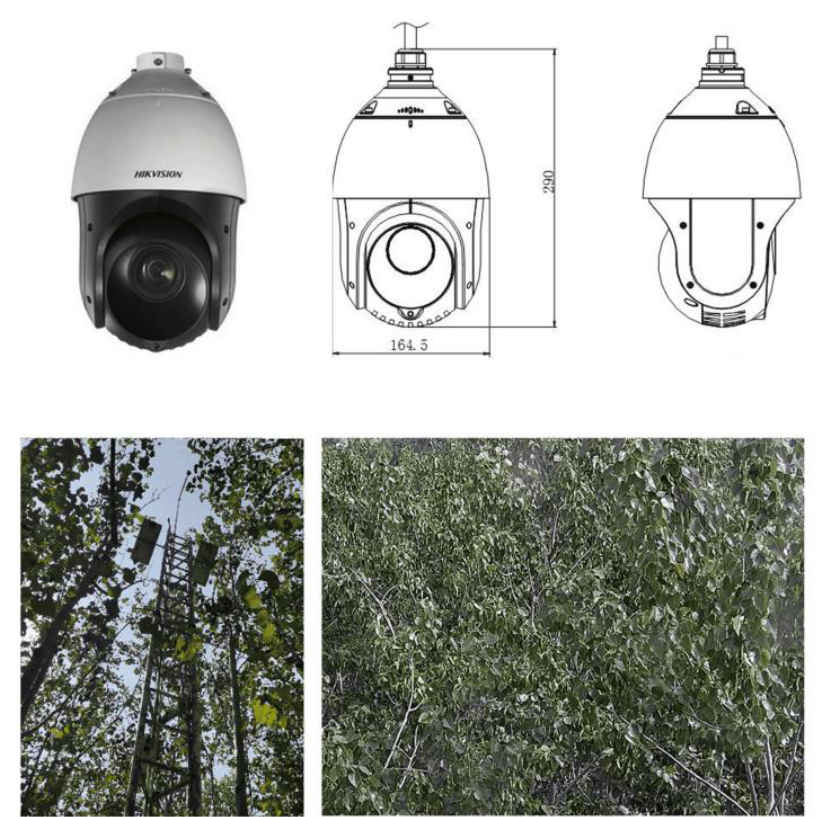
Figure 2. Experimental equipment and installation